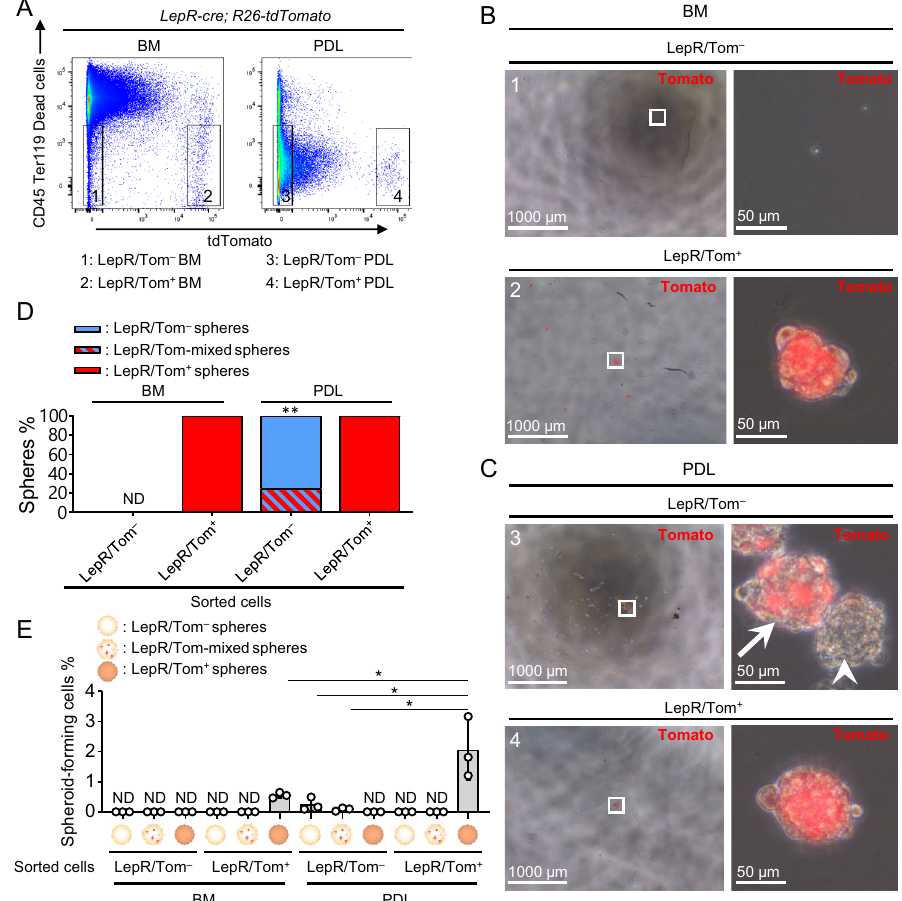
Figure 4. Self-renew stem cell activity is exerted in both LepR/Tom + and LepR/Tom − PDL cell populations. (A–E) Sphere formation assay of bone marrow (BM)- and periodontal ligament (PDL)-derived LepR/Tom + or LepR/Tom − stromal populations. ( A ) Representative FACS plots showing sorted population of BM (left panel, 1: LepR/Tom − , 2: LepR/Tom + ) and PDL cells (right panel, 3: LepR/Tom − , 4: LepR/Tom + ) from LepR-cre ; R26-tdTomato mice. ( B,C ) Representative images of spheres derived from BM ( B ) and PDL ( C ). Arrows: LepR/ Tom-mixed spheres, arrowheads: LepR/Tom − spheres; scale bar = 1000 μm. Right panels are the magnified views of the boxed areas; scale bar = 50 μm. The panel numbers correspond to the gated number in ( A ). ( D ) Frequency of spheroid types; n = 3. Two-tailed Student’s t -test between LepR/Tom − and LepR/Tom-mixed spheres derived from sorted LepR/Tom − PDL cells. ** p < 0.01. ( E ) Frequency of sphere forming cells in the sorted cells; n =